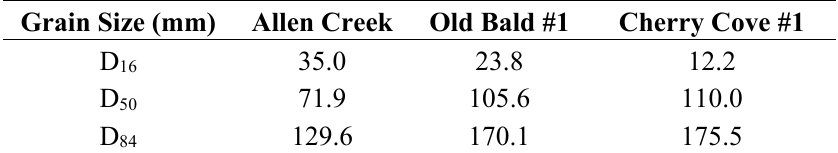
Table 3. Grain size distribution within the channel bed at the three upstream monitoring sites (sizes given in